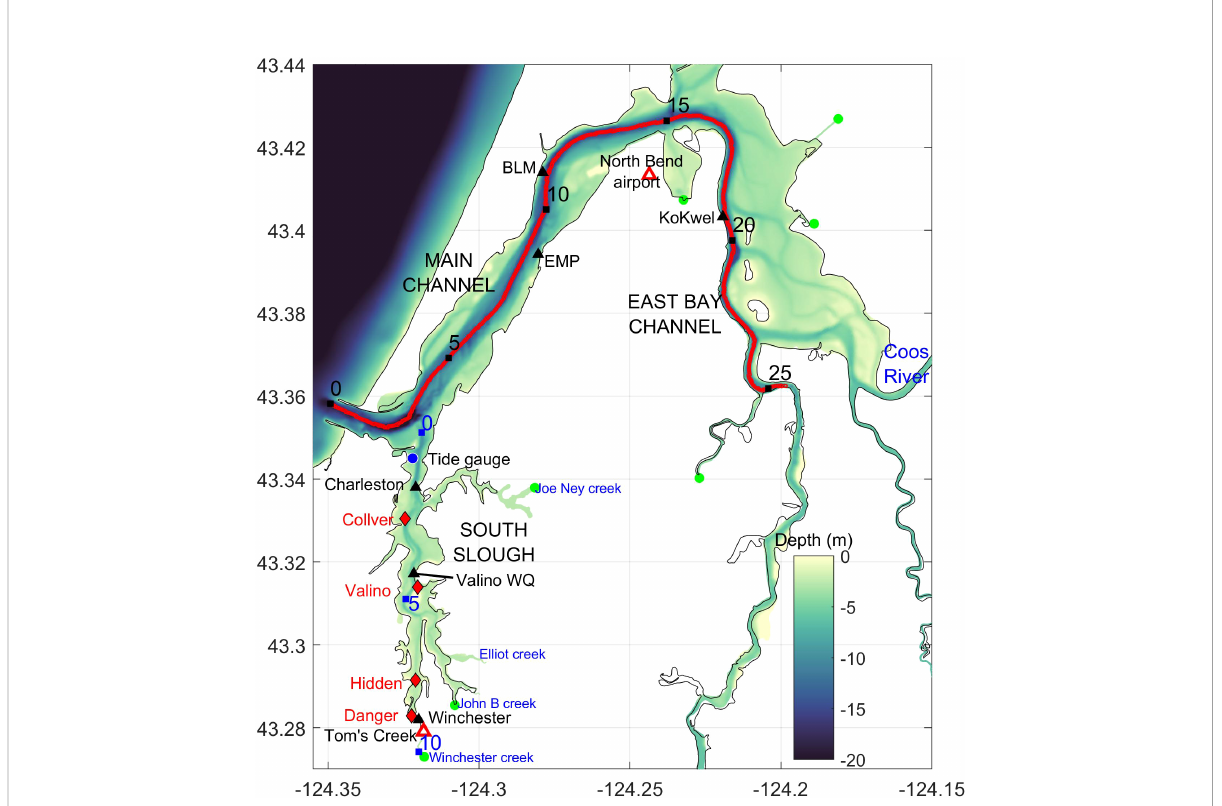
FIGURE 2 The Coos Estuary, showing bathymetry in meters below mean sea level (colored contours) and the location of water quality monitoring stations (black triangles), meteorological stations (red triangle), tide gauge (blue circle), freshwater sources (green circles), and eelgrass stations (red diamonds). Black numbers refer to distance (in km) from the mouth along the thalweg; blue numbers show distance (in km) from the intersection of South Slough with the main